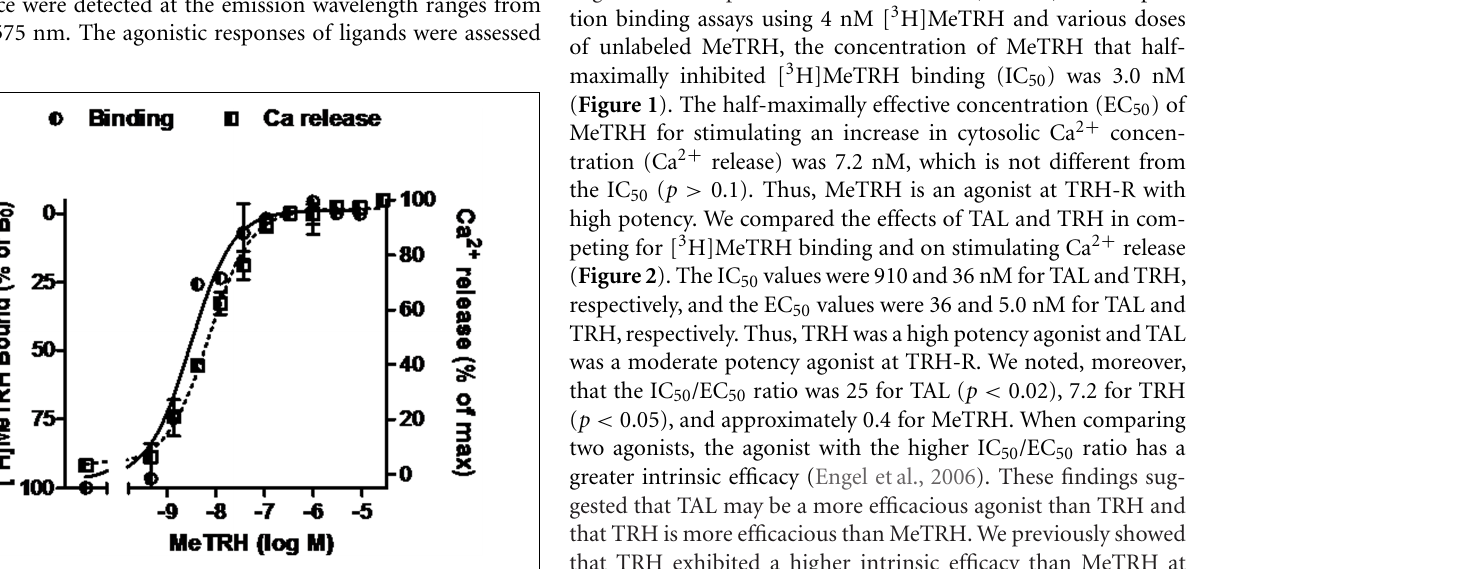
FIGURE 1 | MeTRH binding and signaling via Ca 2 + in cells expressing TRH-Rs. Competition binding with [ 3 H]MeTRH and changes in cytosolic free Ca 2 + concentration (Ca 2 + release) were performed in intact HEK-EM 293 cells stably expressingTRH-Rs as described in Section “Materials and Methods.”The competition binding data are presented as the % of [ 3 H]MeTRH bound to cells in the absence of unlabeled ligand (B 0 ) and represent the results from three experiments conducted with duplicate measurements. Note the left axis is inverted. Intracellular Ca 2 + release data are shown as a % of the maximal Ca 2 + increase over basal.The curves represent the non-linear regression analyses of data obtained in one of three experiments with triplicate measurements using a sigmoidal dose–response method.